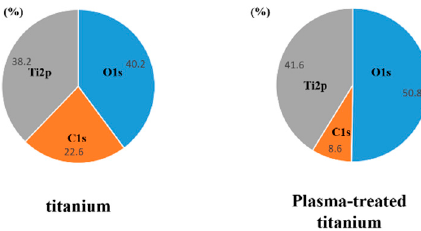
Figure 3. X-ray photoelectron spectroscopy analysis of titanium and plasma-modified titanium. It showed the intensity of the O1s peaks increased while that of the C1s peaks decreased in response to plasma irradiation.